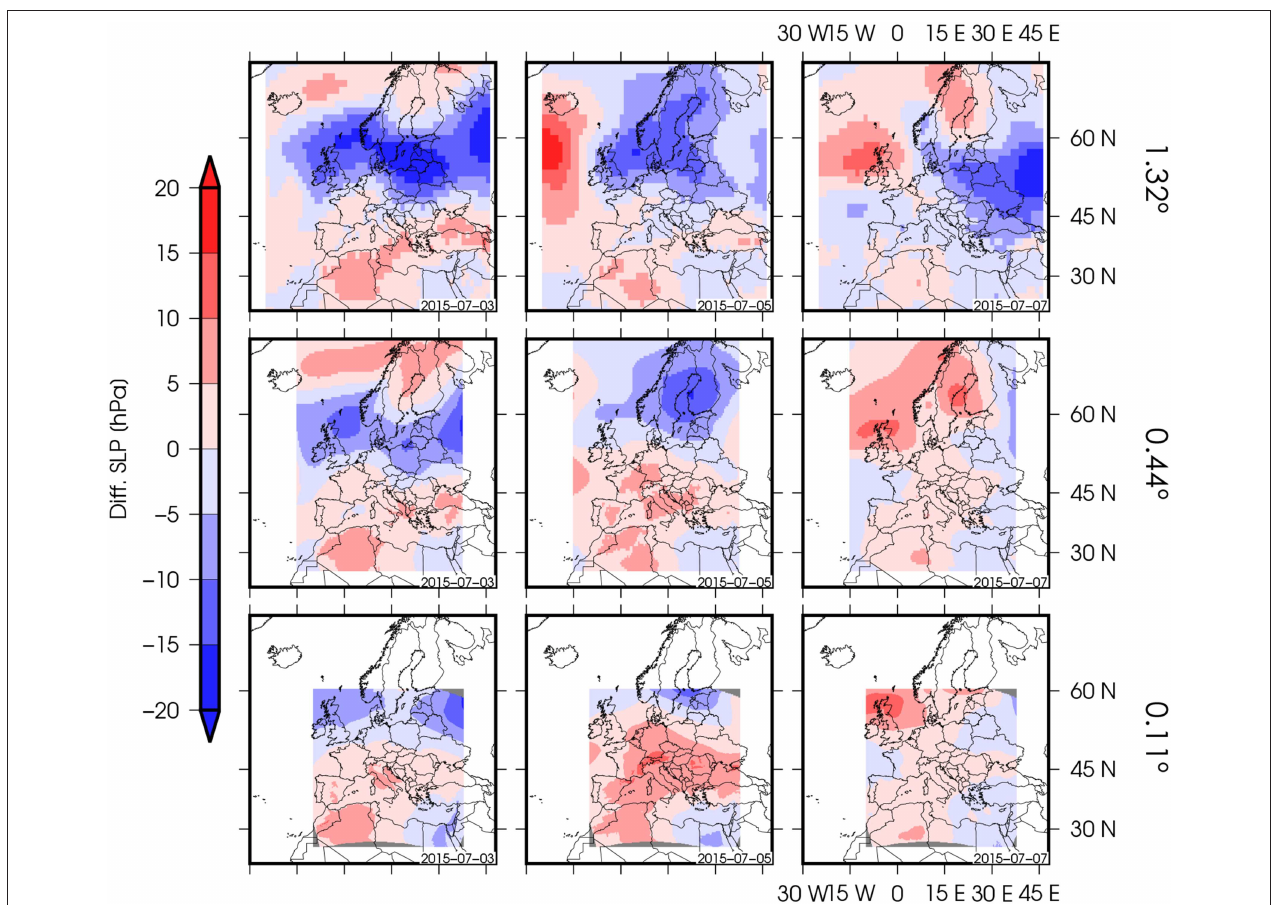
FIGURE 4 | Daily SLP differences between ERA5 and simulations at different resolutions: top row, at 1.32 ◦ ; second, at 0.44 ◦ ; and at 0.11 ◦ in third row. Selected days are 3rd, 5th, and 7th of July (left, center, and right,